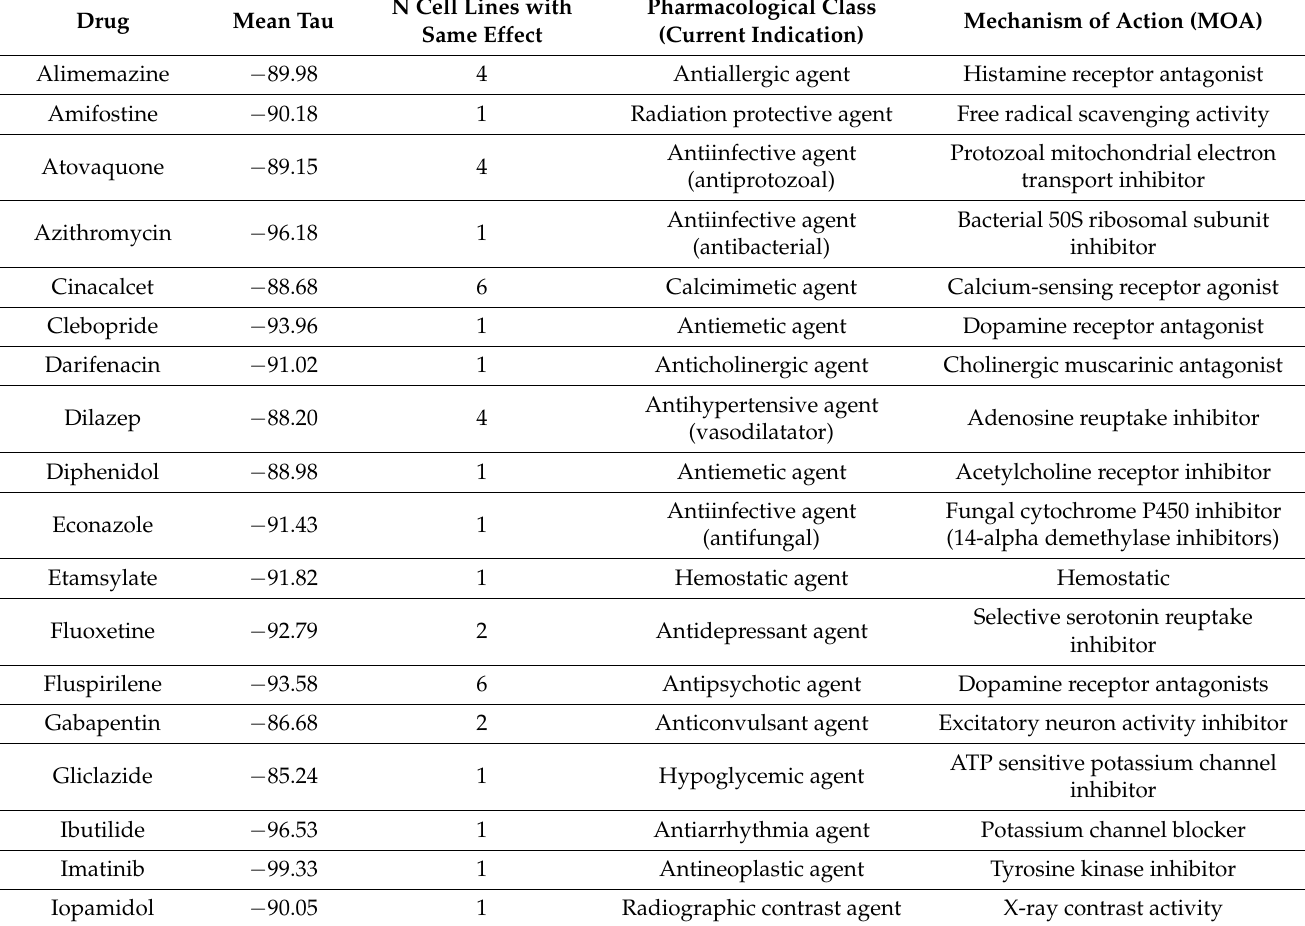
Table 2. Final list of 37 repurposable drug candidates with a potential to reverse transcriptomic signature upon SARS-CoV-2 infection (sorted in alphabetical order).